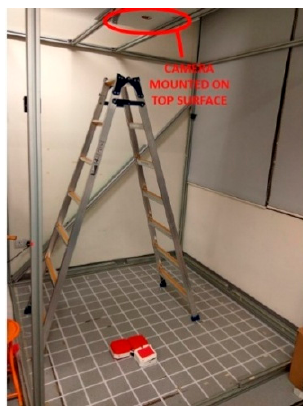
Figure 15. Test area with parallelepiped structure with provision for camera mount.